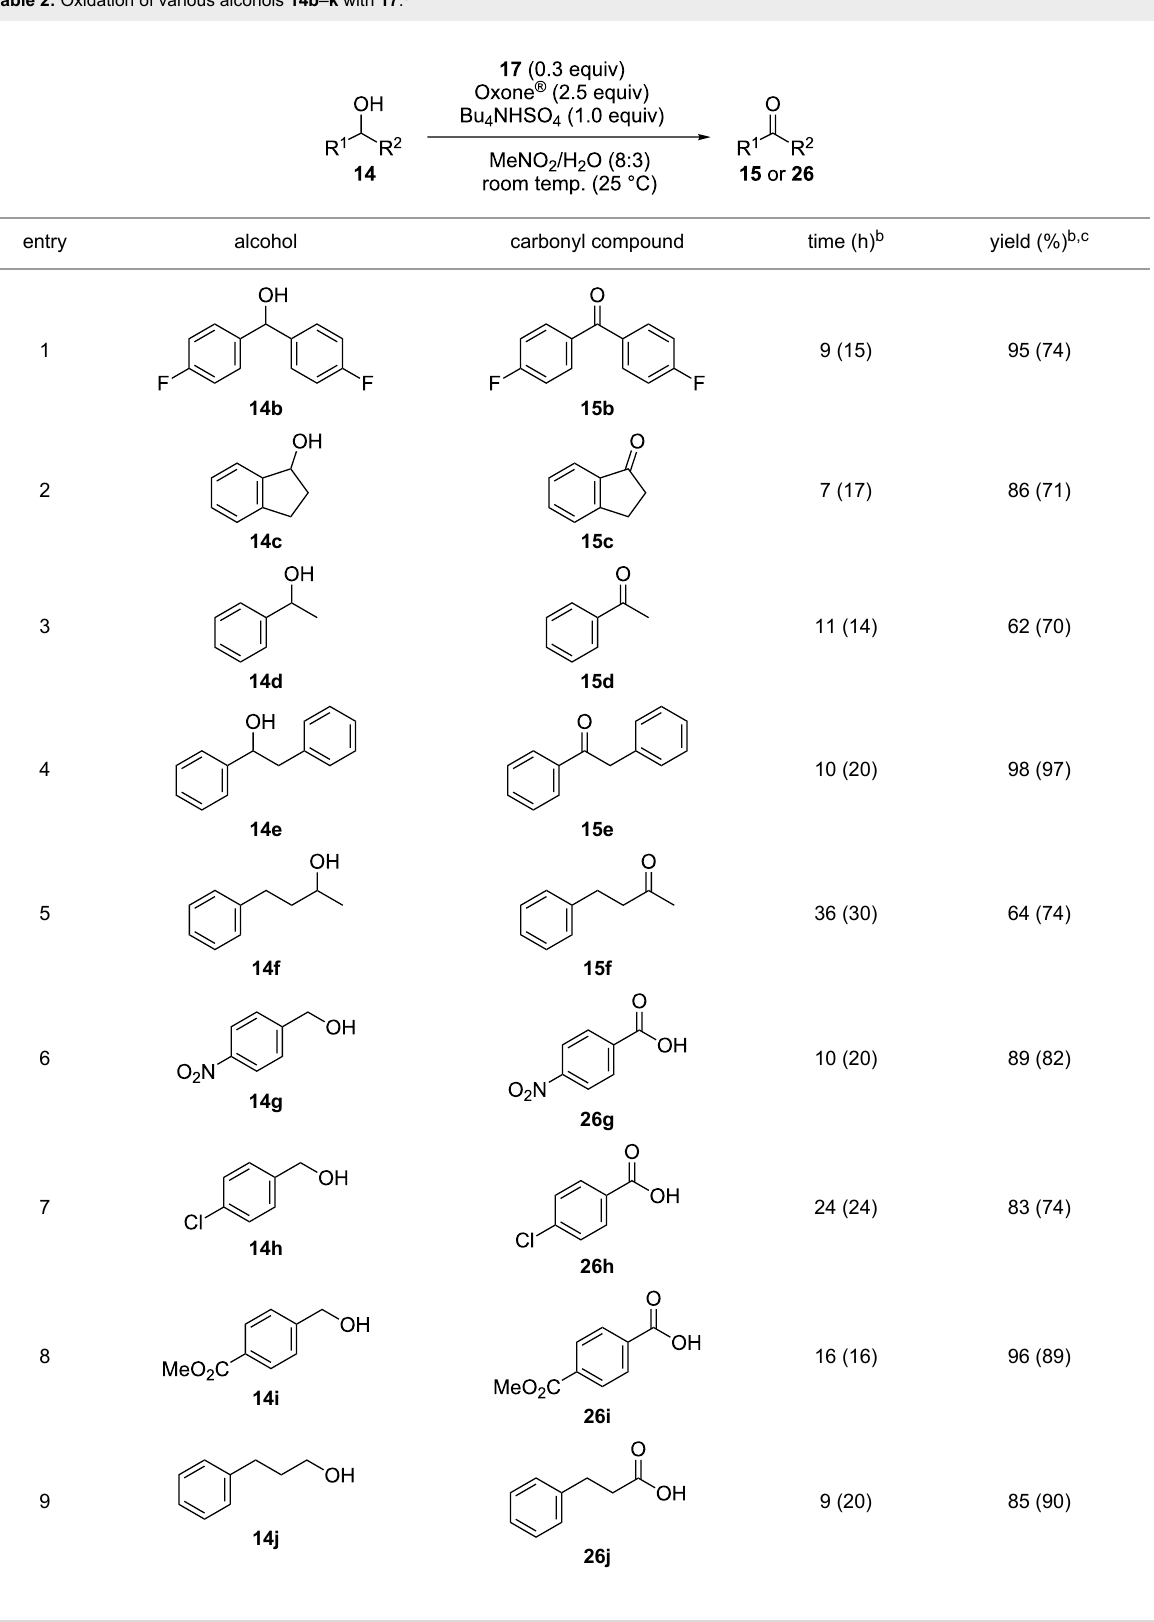
Table 2: Oxidation of various alcohols 14b – k with 17 .